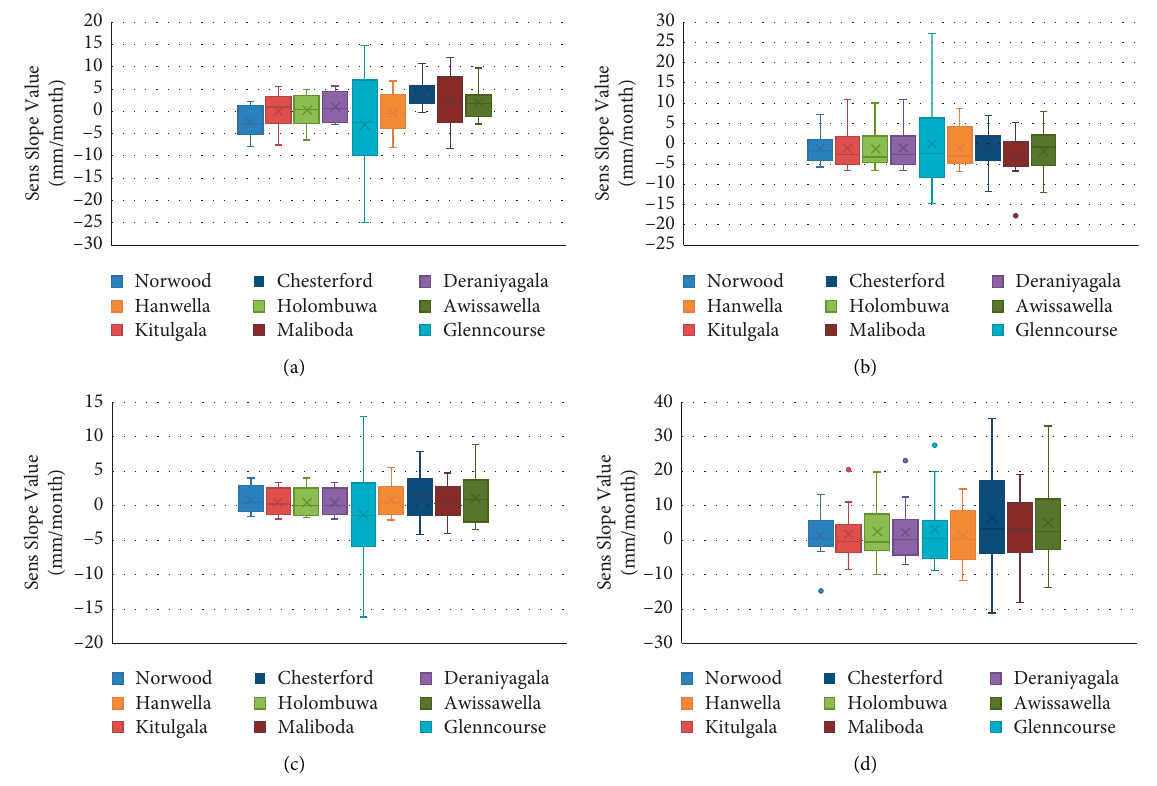
Figure 7: Results of nonparametric test. (a) For observed data. (b) For PERSIANN. (c) For PERSIANN-CDR. (d) For